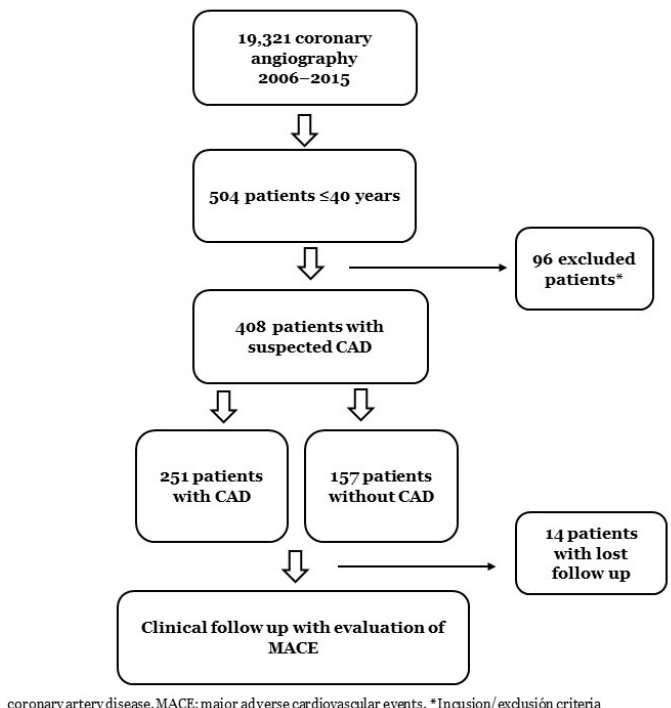
Figure 1. Flow chart diagram of the study population.